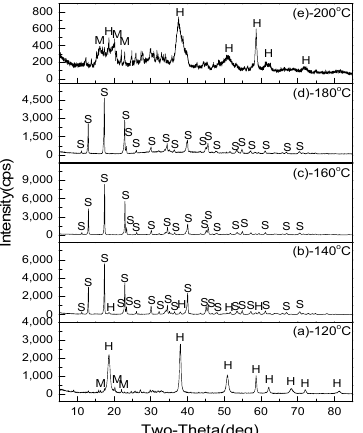
Figure 12. XRD patterns of whiskers obtained at different hydrothermal temperatures H-Mg(OH) 2 , S-5Mg(OH) 2 ·MgSO 4 ·2H 2 O, M-MgSO 4 ·xH 2 O.